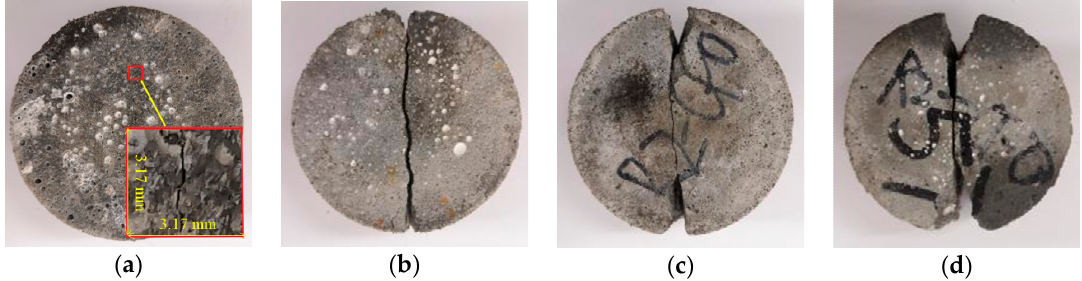
Figure 6. Failure patterns of specimens under room temperature and various strain rates (the incident bar is above the specimen), ( a ) 14.86 s − 1 , ( b ) 18.84 s − 1 , ( c ) 23.84 s − 1 , ( d ) 26.32 s − 1 .